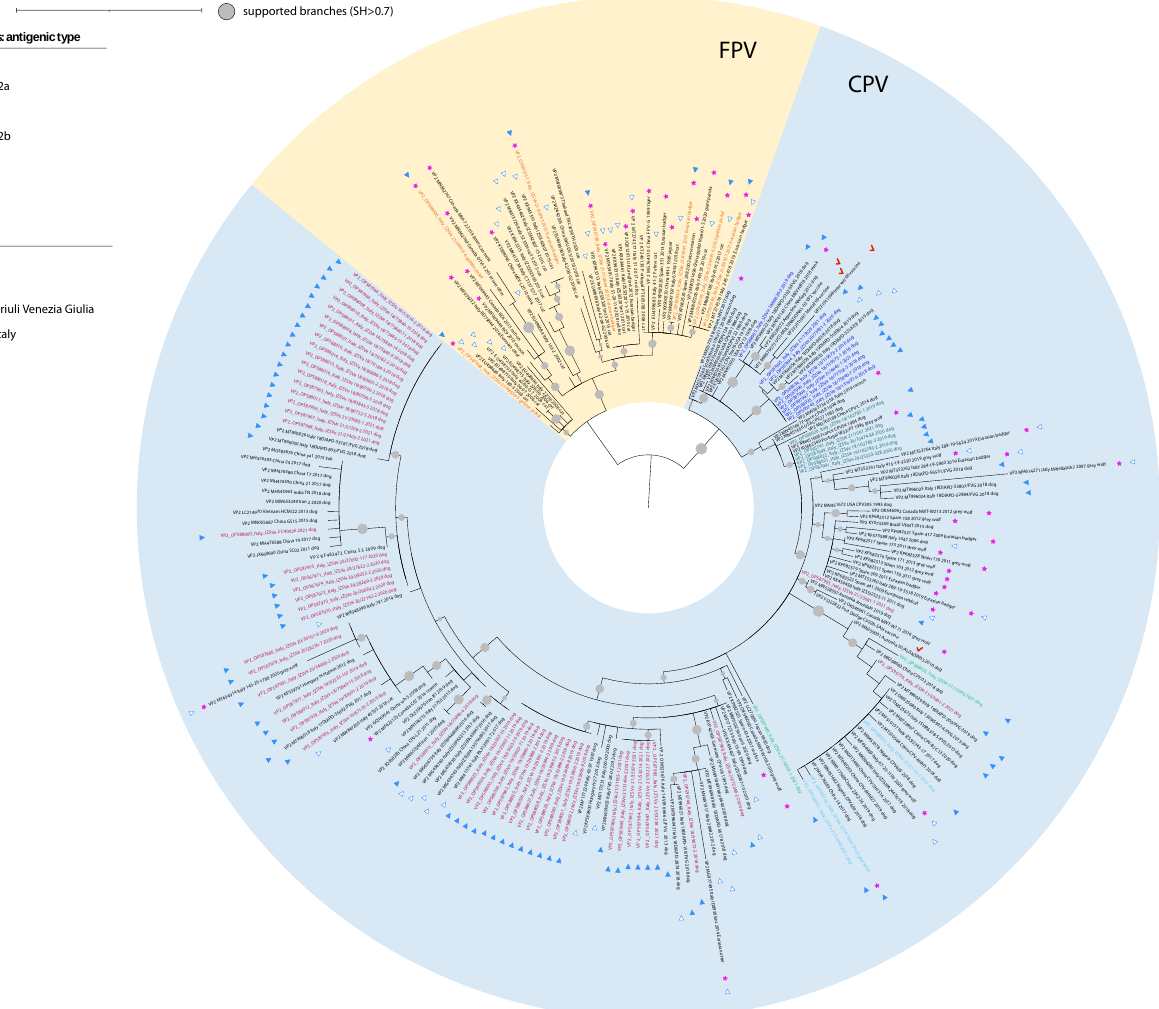
Figure 1. ML phylogenetic tree of Carnivore Protoparvovirus 1 analyzed in this study, based on the complete VP2 gene sequences, divided in canine (blue) and feline (yellow) parvoviruses. Branches supported with SH value higher than 0.7 are marked with grey circles, with size proportional to the SH value. Original strains sequenced for this work are shown with colored labels based on their antigenic classification as CPV-2 (blue), new CPV-2a (red), CPV-2b (petrol), new CPV-2b (green), CPV-2c (light blue). Sequences (original and reference) associated with wildlife and found in the study area are indicated with pink stars and blue circles, respectively (full for the region of Friuli Venezia-Giulia and empty for some other areas in Italy), while vaccine strains are marked with a red